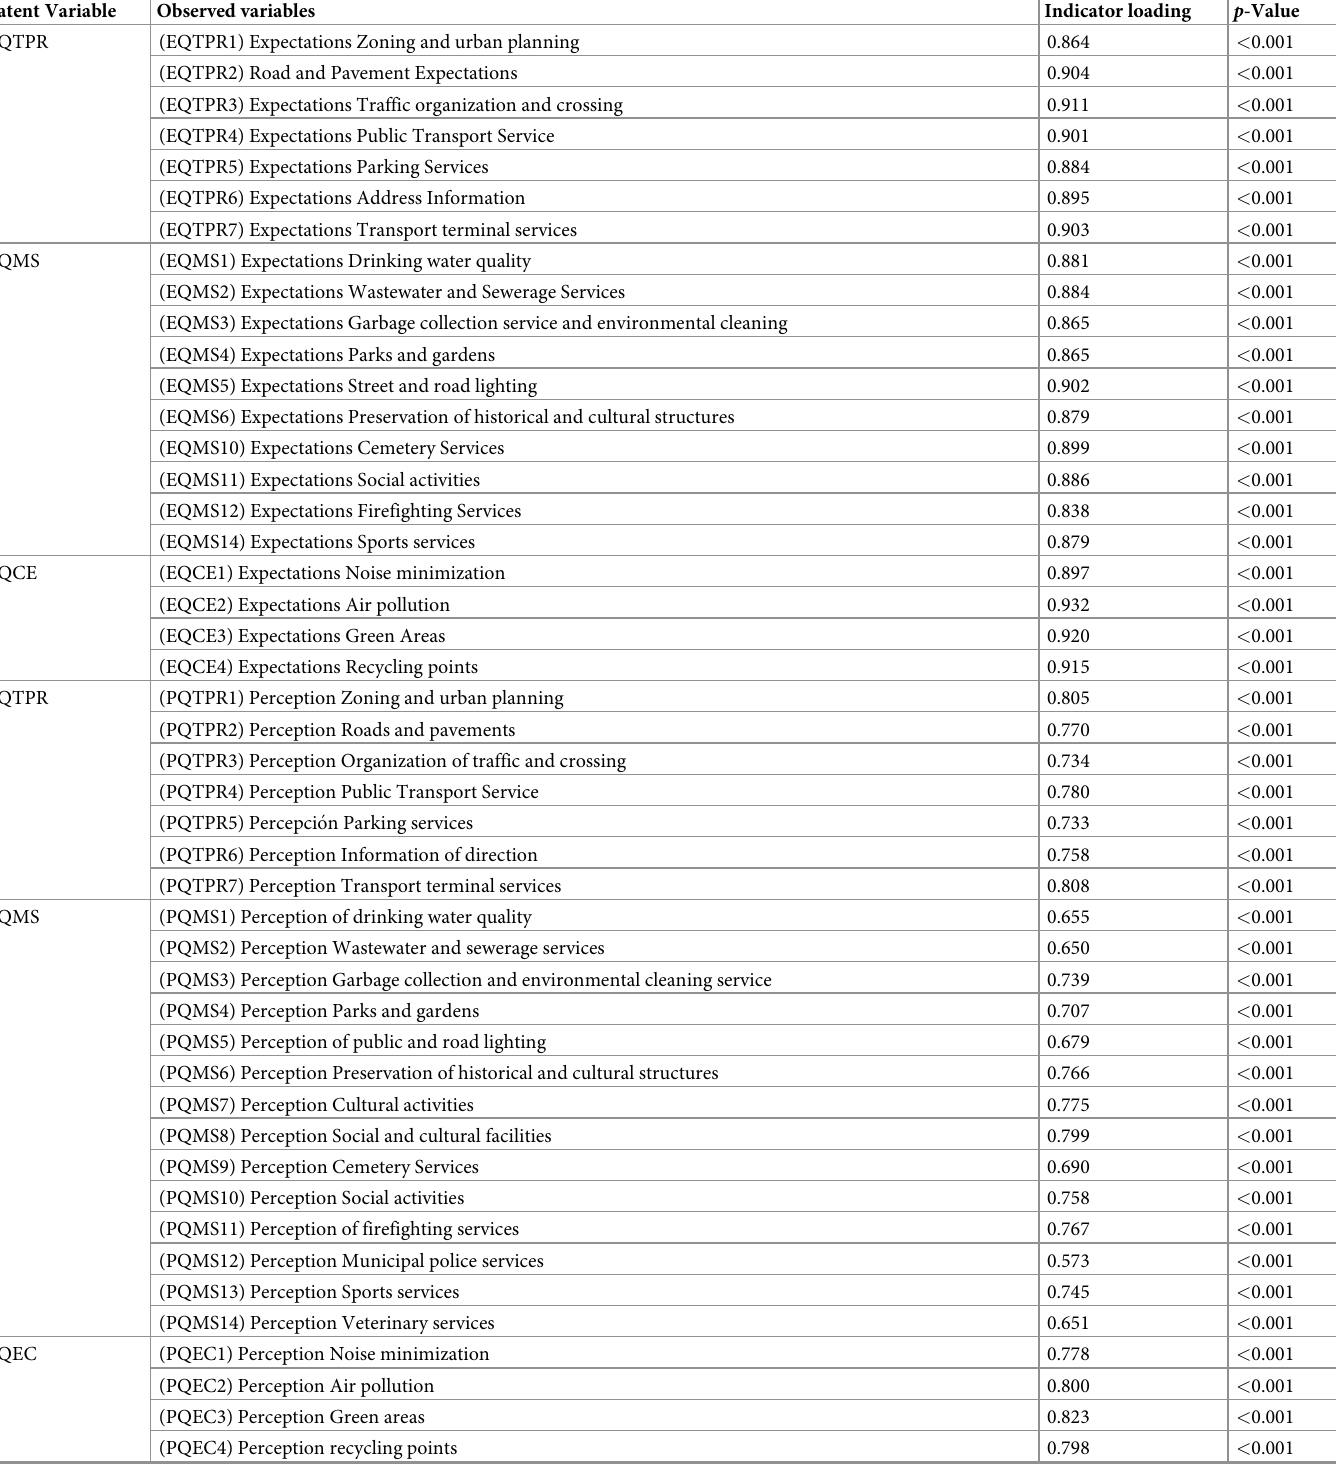
Table 4. Indicator loading of the observed